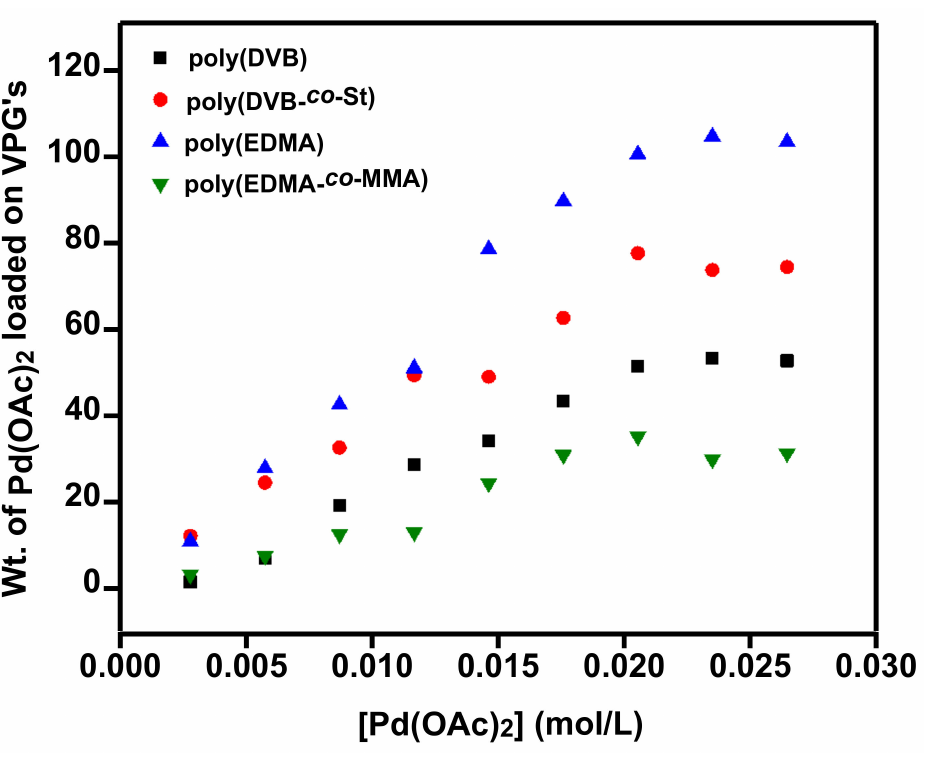
Figure 1. Maximum capacities test in loading Pd(OAc) 2 to VPGs. [conditions: VPG = 50 mg, methanol = 50